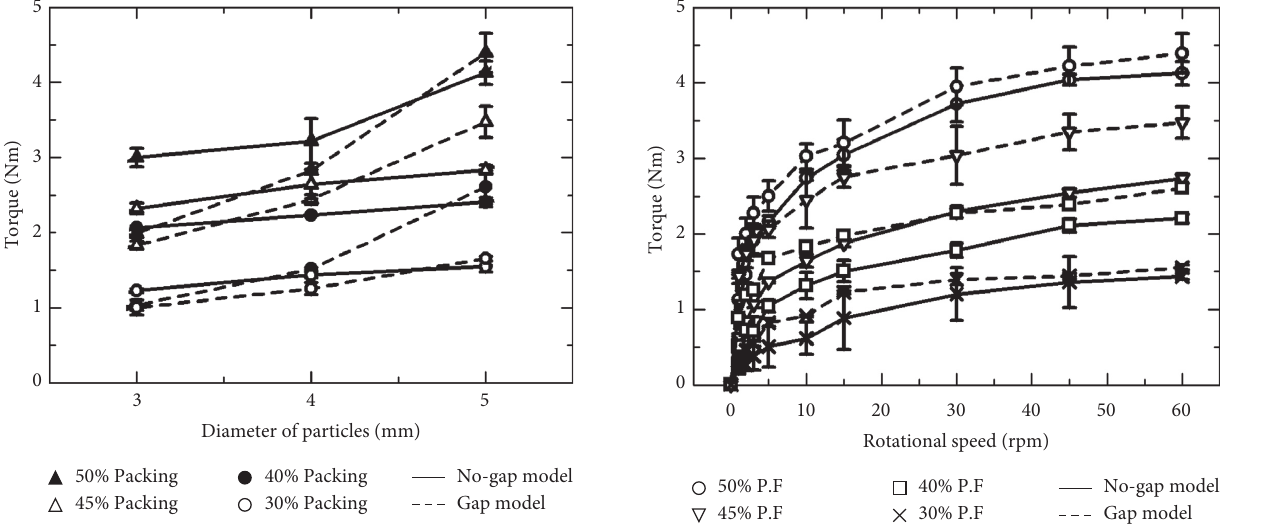
Figure 14: The torque versus rotational speed curve of the rotary damper with gap and no-gap models using 5mm diameter elas- tomer